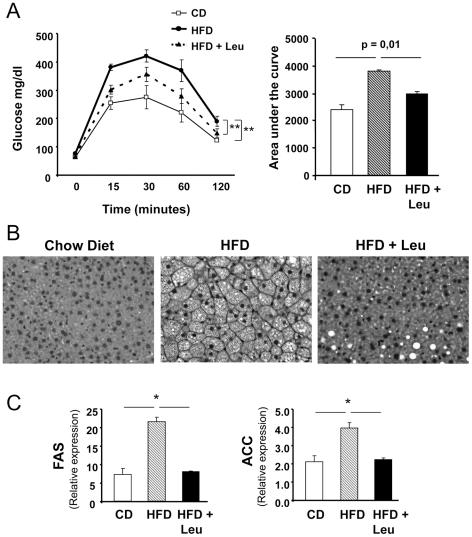
Leucine supplementation improves glucose tolerance and hepatic steatosis in mice on HFD.A) Glucose tolerance tests were performed after an overnight fast in the three study groups. Mice received an intraperitoneal injection of 2 g/kg body wt glucose. Glucose was measured in tail vein blood samples at the indicated times. The area under the curve (AUC) was calculated for each dietary condition. Data points are means ± SEM with 7–8 mice in each group. B) Mice were sacrificed and livers were harvested after 8 weeks on each diet. The livers were then formalin fixed, embedded in paraffin and sections stained with H&E. Three mouse livers per group were analyzed. C) mRNA was extracted from 200 mg liver and subjected to quantitative real time PCR. Gene expression for FAS and ACC were normalized against TATA-binding protein (TBP). 5 livers per group were used. *P<0.05.